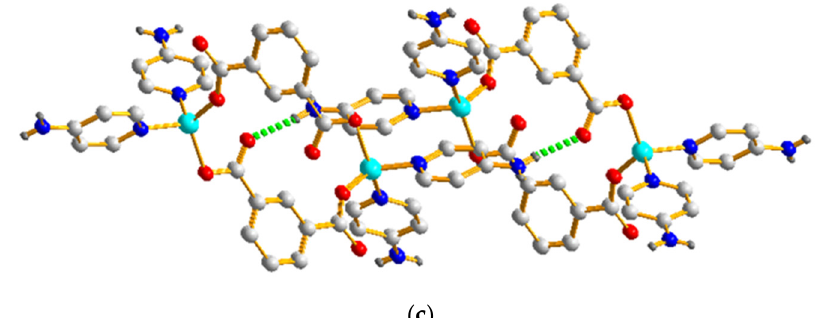
Figure 4. ( a ) Coordination environment of Co(II) ion in 4 . Symmetry transformations used to generate equivalent atoms: (A) 1 − x, 0.5 + y, 0.5 − z. ( b ) The Co(II) ions are linked by 1,3-BDC 2 − ligands to form